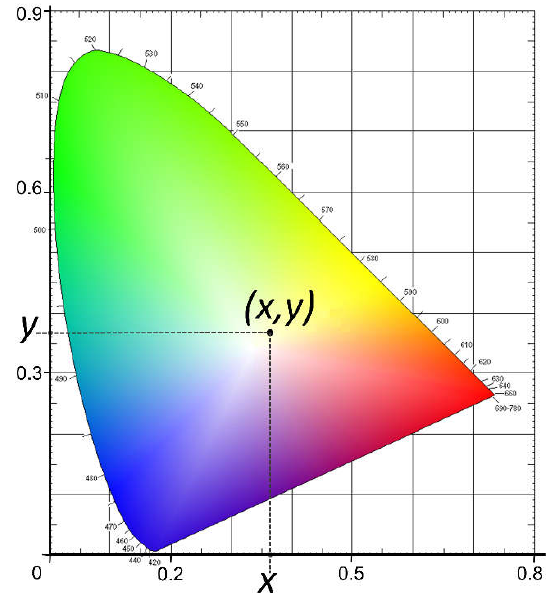
Figure 1. Representation of a CIE three–dimensional color–space diagram.